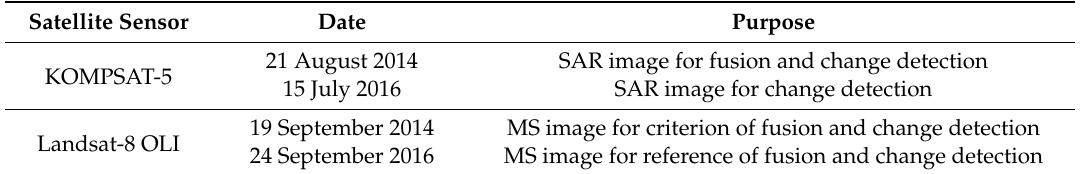
Table 1. The date and purpose of the experimental images used in this